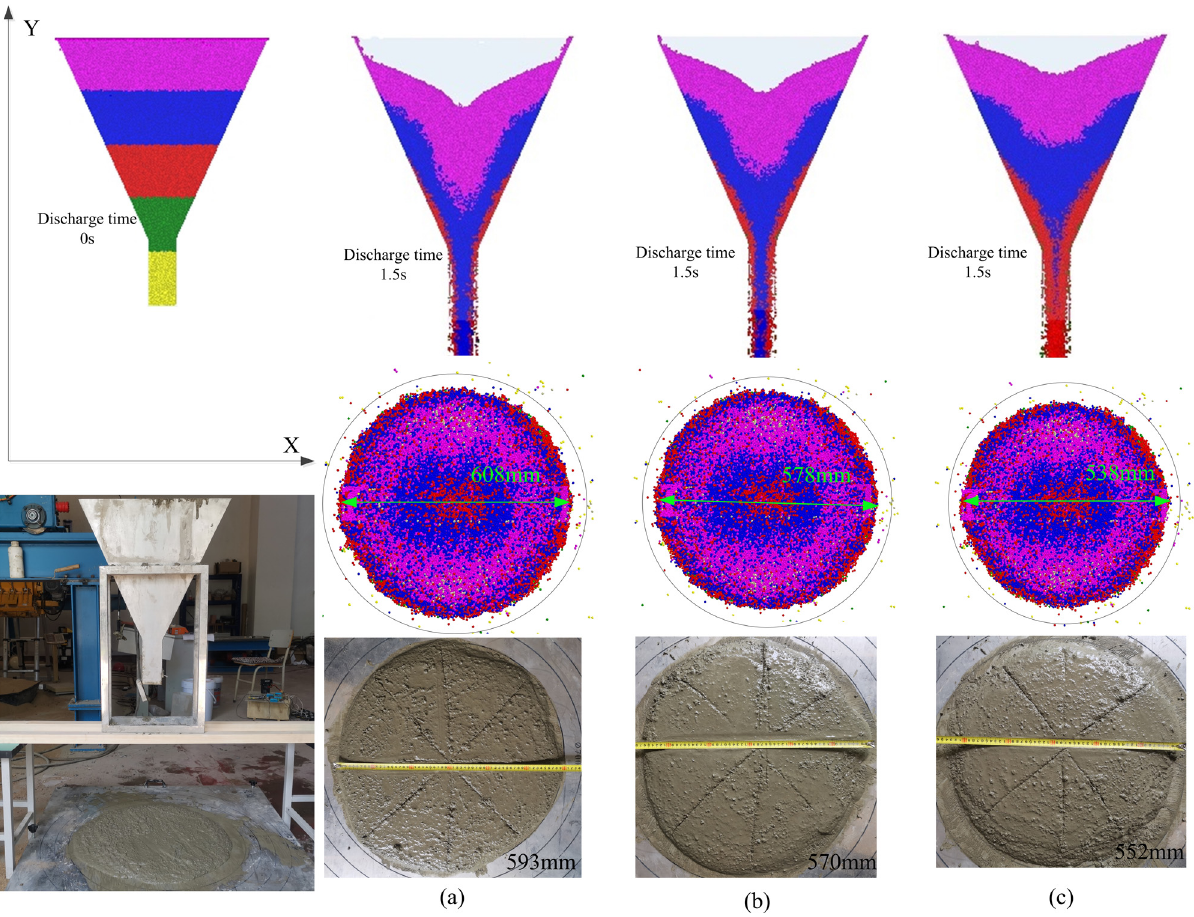
Figure 11: Snap - shots of discharging concrete in V - funnel experiment ( bottom ) and the DEM simulation ( top ) for the di ff erent batch times: ( a ) 5 min, ( b ) 15 min, and ( c ) 25 min.